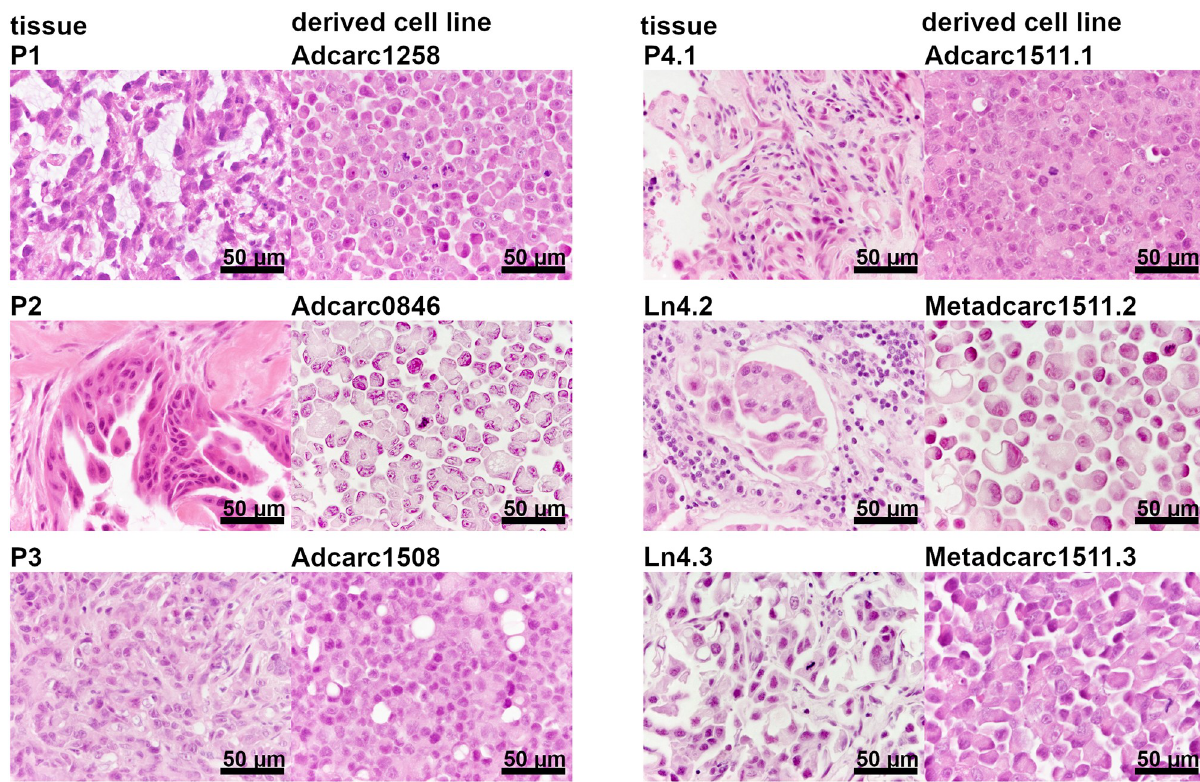
Fig 1. Formalin-fixed and HE-stained PAC tissue samples and cell